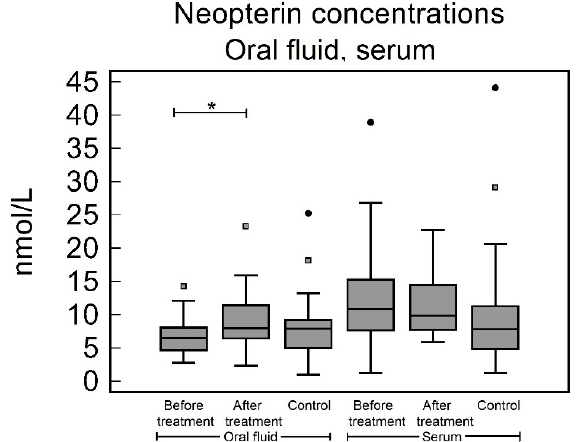
Figure 3. Neopterin concentrations in oral fluid and serum. In oral fluid, Np concentrations were significantly higher after periodontal treatment when compared to pretreatment levels ( p = 0.02). In oral fluid, when compared with control group, Np concentrations in study group both, before and after treatment, were not significantly different ( p = 0.27 and 0.5, respectively). In serum no significant difference was observed ( p = 0. 72, study group before treatment vs. after treatment; p = 0.23, study group before treatment vs. control group; p = 0.14, study group after periodontal treatment vs. control group. * p < 0.05.